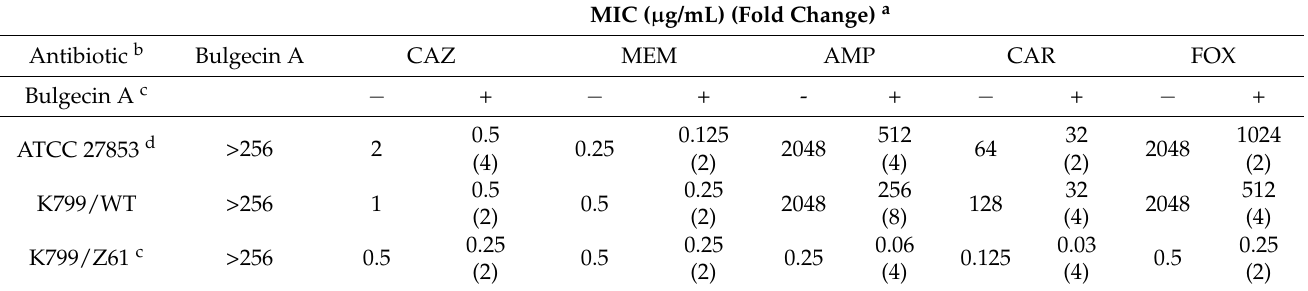
a The fold change of the MIC in the presence of bulgecin A is indicated in the brackets. b AMP, ampicillin; CAR, carbenicillin; CAZ, ceftazidime; FOX, cefoxitin; MEM, meropenem. c The concentration of bulgecin A was 100 µ g/mL. d A reference strain ATCC27853 was used as a quality control of the antibacterial susceptibility. The experiments were performed in triplicate independently. We measured the MIC of CAZ and MEM against two knockout mutants in the absence and in the presence of bulgecin A (Table 2). The MIC values of MEM were reduced as much as 8- and 4-fold, respectively, for the ∆ 3-MCS ( ∆ mexAB / ∆ mexXY / ∆ mexCD ) and (Table 2), compared to the wild-type PAO1. This indicates that MEM may be pumped out through one of three efflux systems ( mexAB , mexXY or mexCD ). On the other hand, the MIC